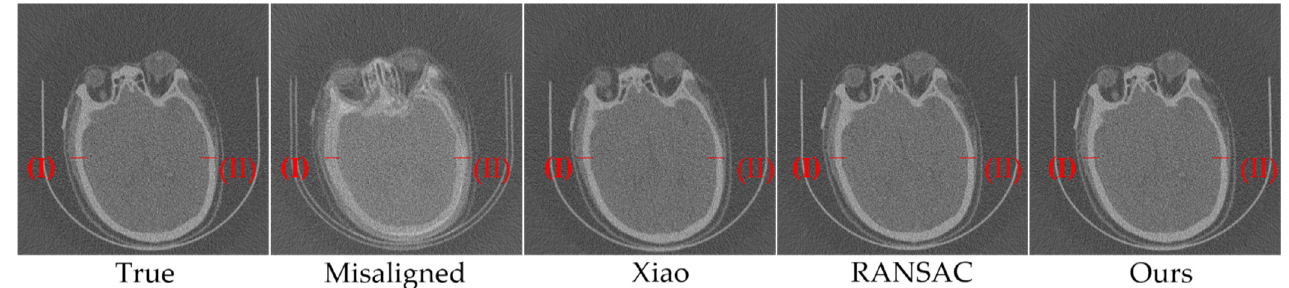
Figure 6. Comparison of 2D slices after calibration parameter reconstruction under 20% noise.